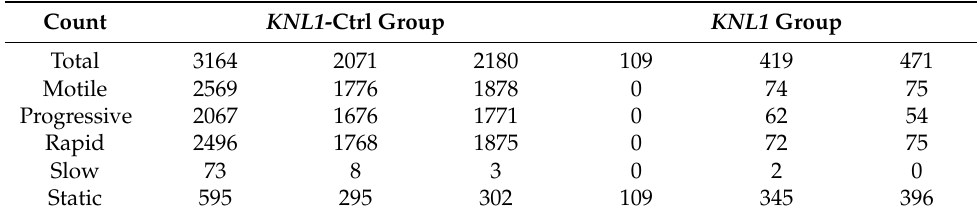
Table 2. The CASA count number data of KNL1 -Ctrl and KNL1 -60 µ g Group mice.